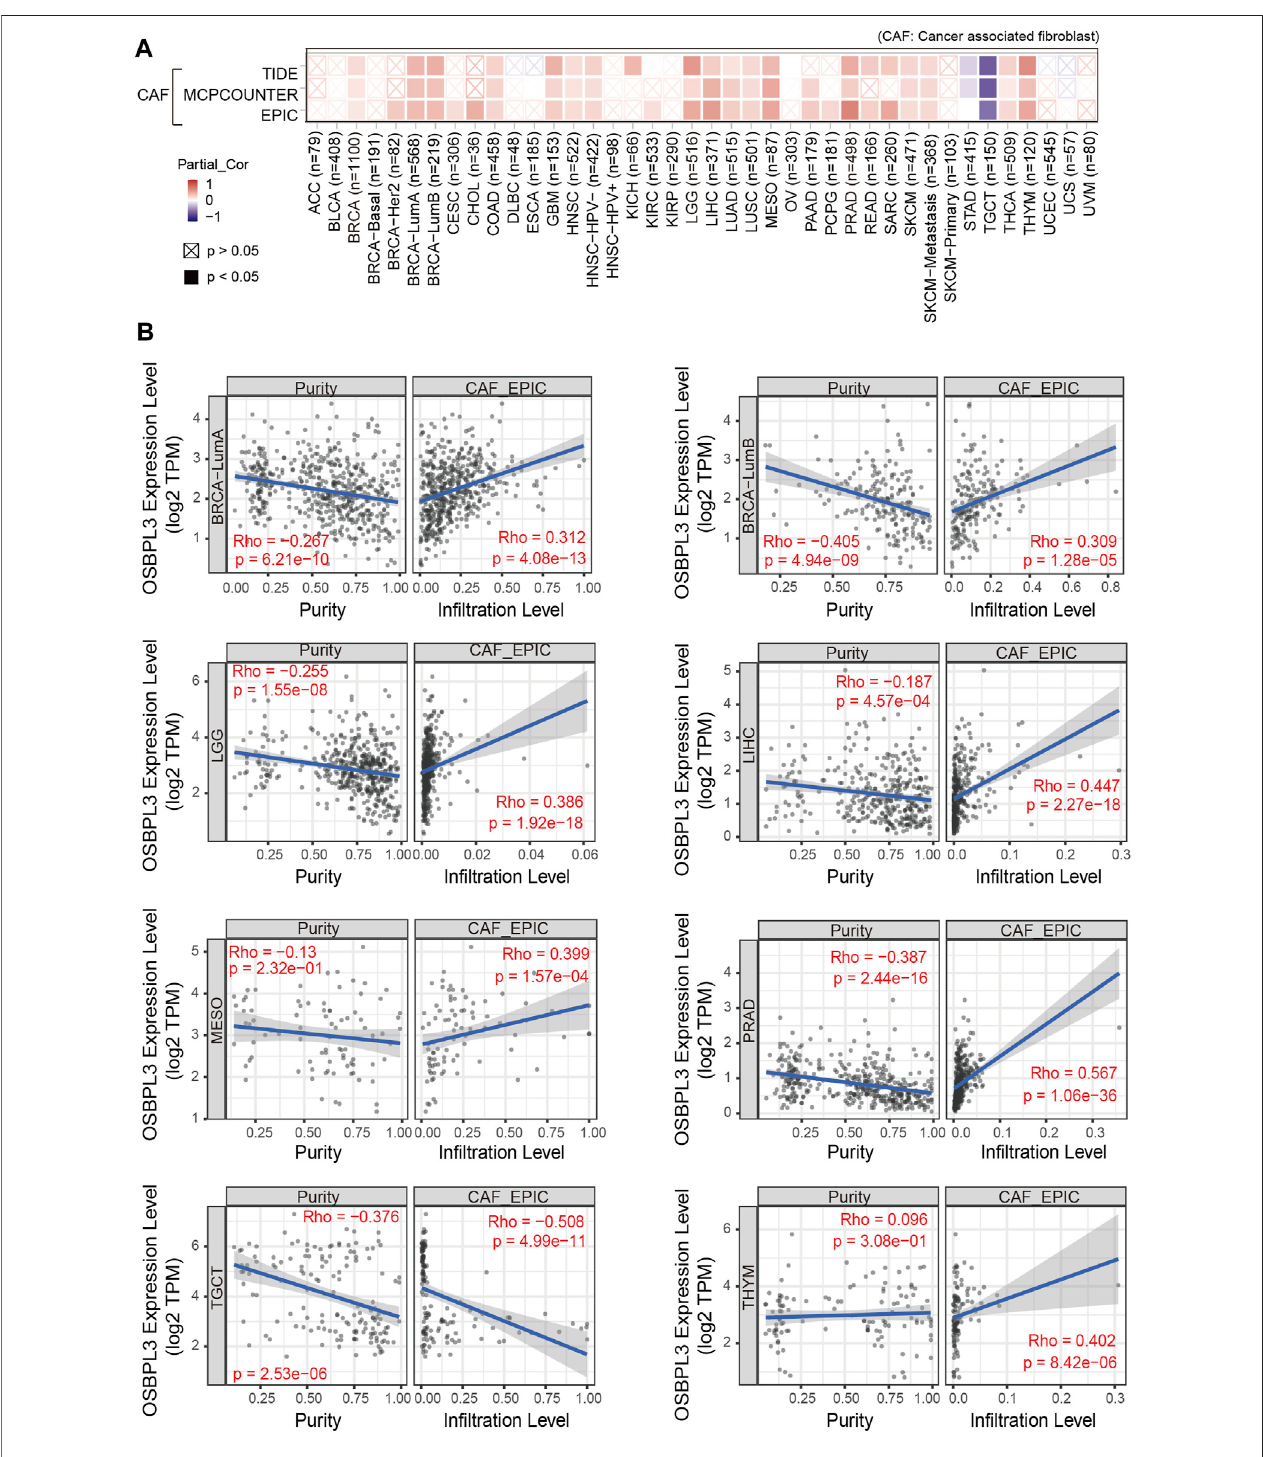
FIGURE10| CorrelationanalysisbetweenOSBPL3expressionandin fi ltrationofcancer-associated fi broblasts(CAFs). (A) Heatmapsofin fi ltrationlevelofOSBPL3 gene expression and CAFs in multiple tumor tissues (horizontal axis: different tumor tissues; vertical axis: different immune scores; different colors represent correlation coef fi cients. The stronger the correlation, the darker the color. The Wilcox test was performed. * p < 0.05; ** p < 0.01; *** p < 0.001). (B) Correlation between the expression level of OSBPL3 gene and the in fi ltration level of CAFs in BRCA-luminal A, BRCA-luminal B, LGG, LIHC, MESO, PRAD, TGCT, and THYM (Spearman correlation analysis was